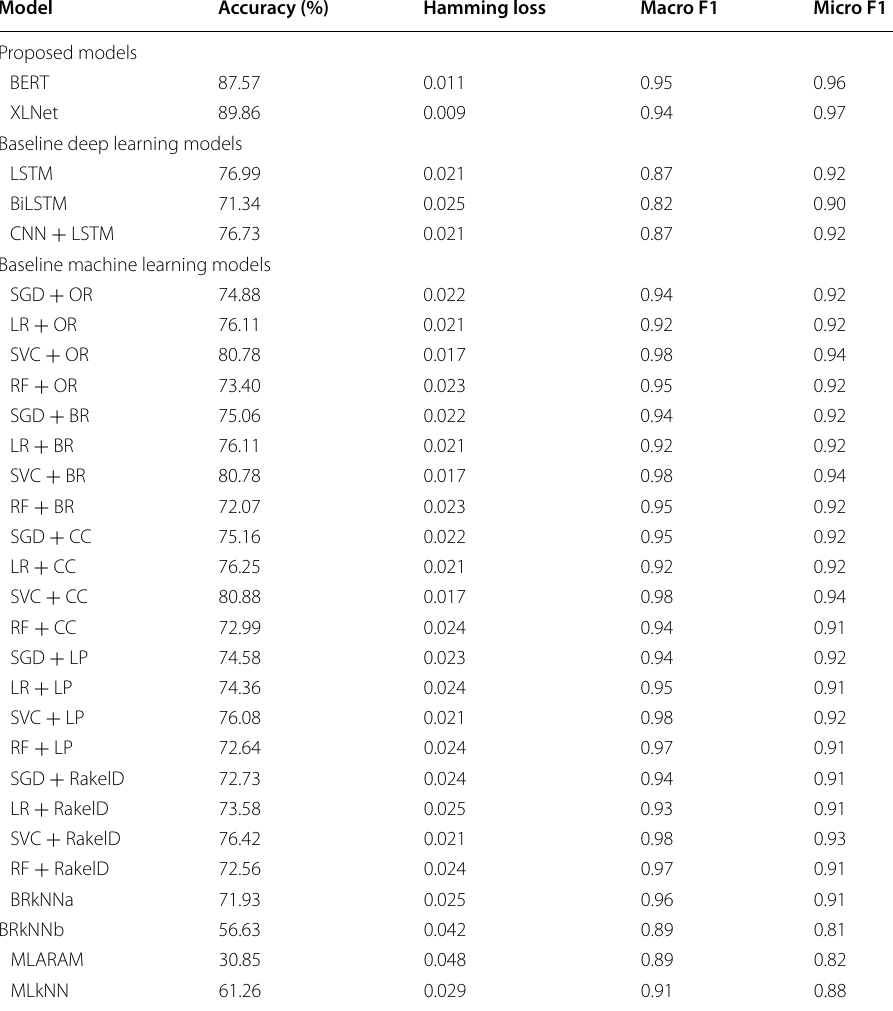
Table 11 Experiment results of movie reviews Model Accuracy (%) Hamming loss Macro F1 Proposed